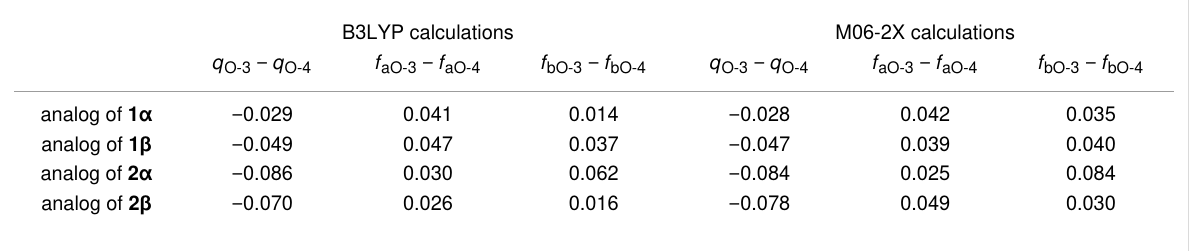
Table 2: Differences of charges and Fukui functions of the O-3/O-4 positions for analogs of acceptors 1 α / β and 2 α / β